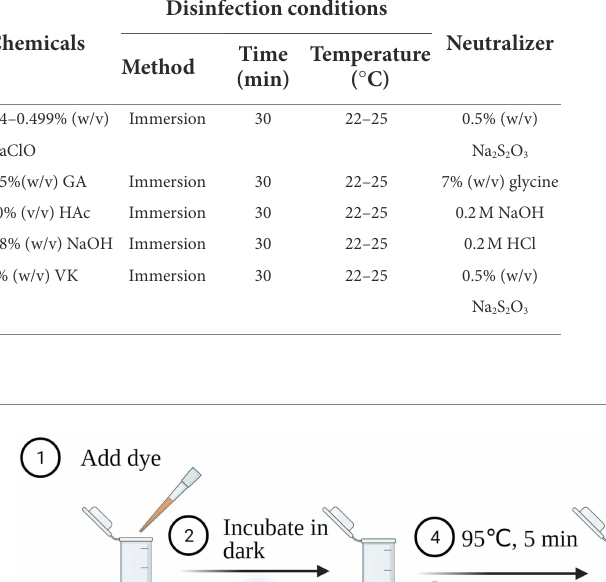
TABLE 1 Chemicals and corresponding neutralizers used for ASFV disinfection.